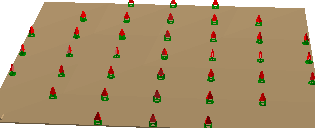
Figure 3. Array of 37 H.E.S.S.-I telescopes used in the simulation of various